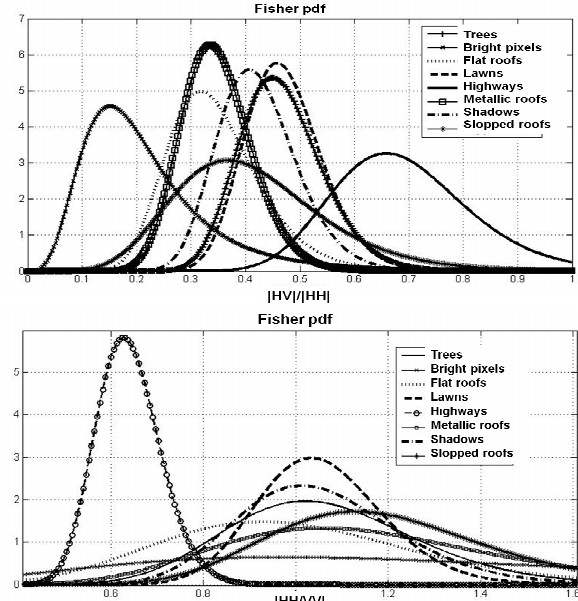
Figure 3. Estimated Fisher distribution by MoML for the eight classes and two different